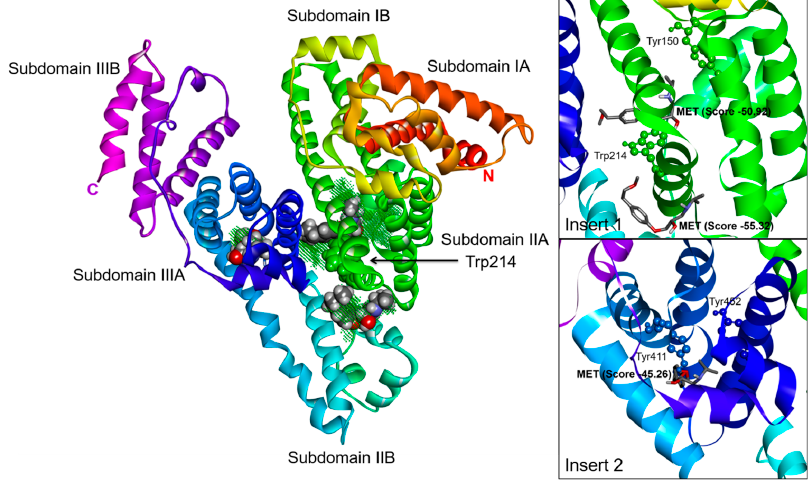
Figure 5. Computational structure of HSA (PDB 1AO6) complexed with metoprolol (METs). In the